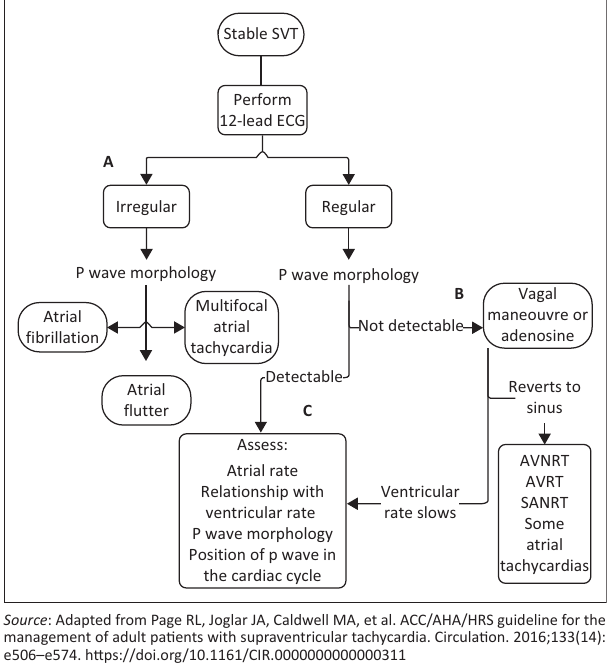
FIGURE 3: Evaluation of supraventricular tachydysrhythmias.